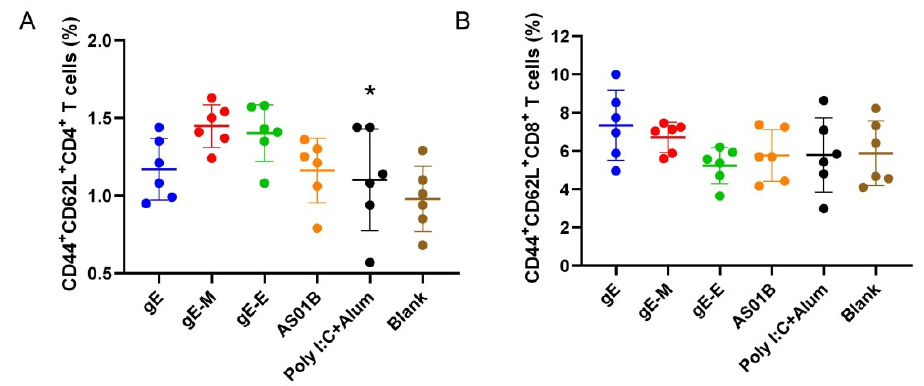
Figure 5. Flow cytometry assay for memory T cells. ( A ) Proportion of memory CD4+ T cells among splenocytes after stimulation with gE; ( B ) proportion of CD8+ memory T cells among splenocytes after stimulation with gE. Data were analyzed using one-way ANOVA followed by Dunnett’s multiple comparisons test, with the gE-M group as a control. * p < 0.05.